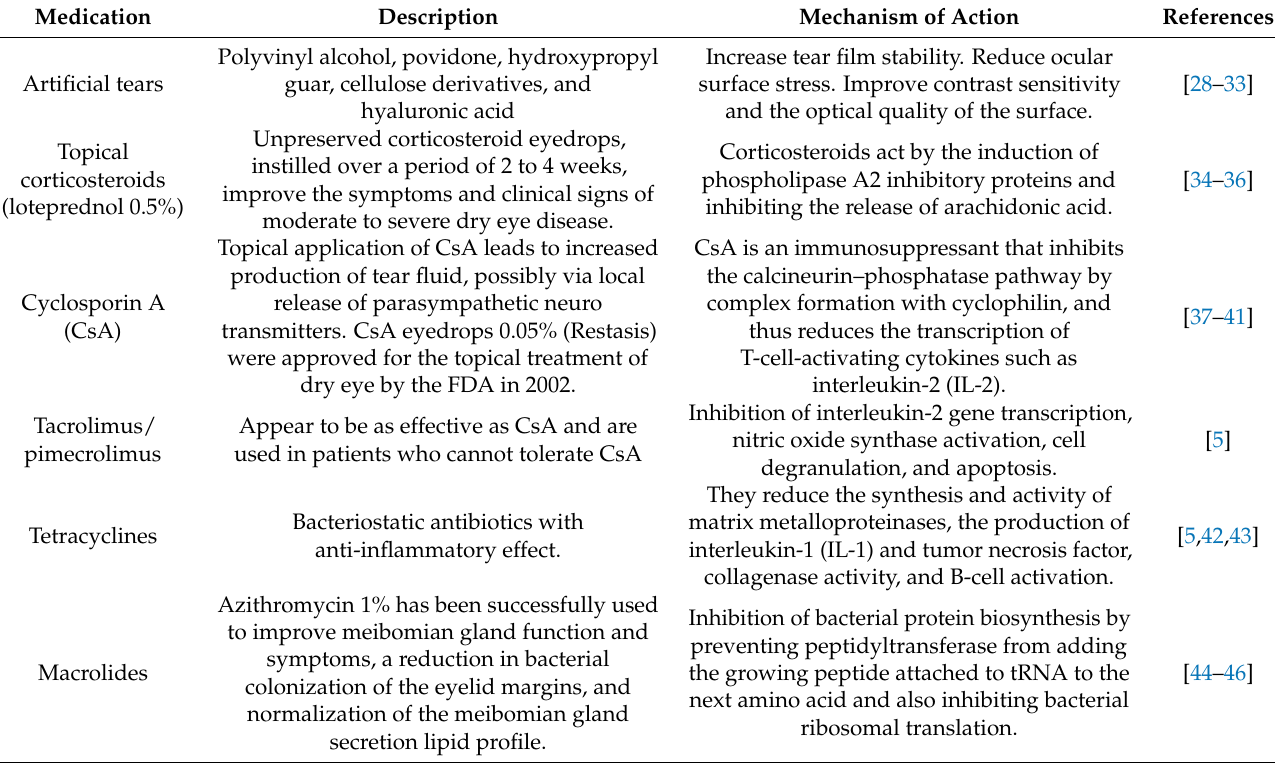
Table 1. Dry eye disease